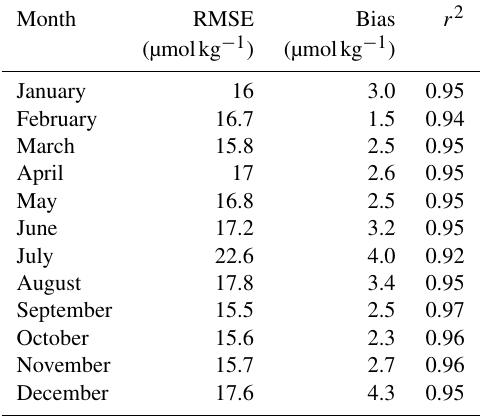
Table 7. Comparison of the monthly TCO 2 climatology of Taka- hashi et al. (2014) and the one of the present